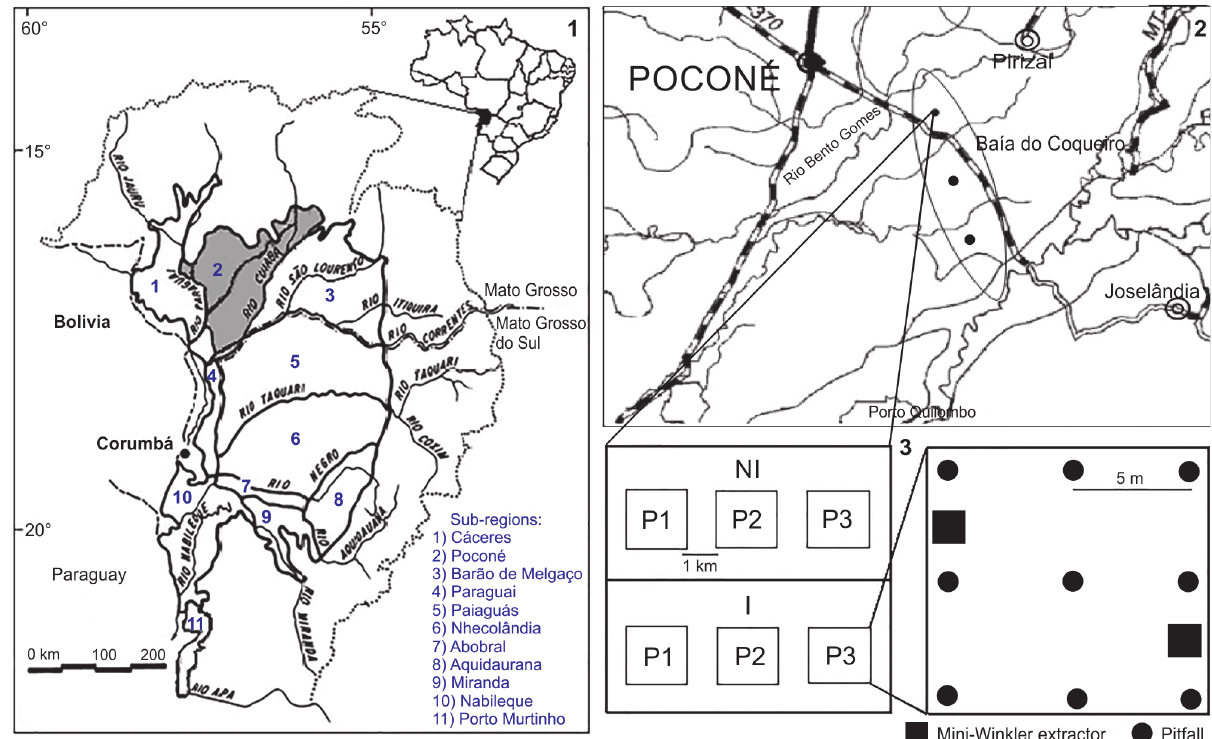
Figures 1–3. (1) The Pantanal and its 11 sub-regions, with emphasis on the Pantanal of Poconé, Mato Grosso, Brazil. (2) Study area with the location of the three sample units (A1, A2 and A3), along the Porto Cercado Road, between the Bento Gomes and Cuiabá rivers,